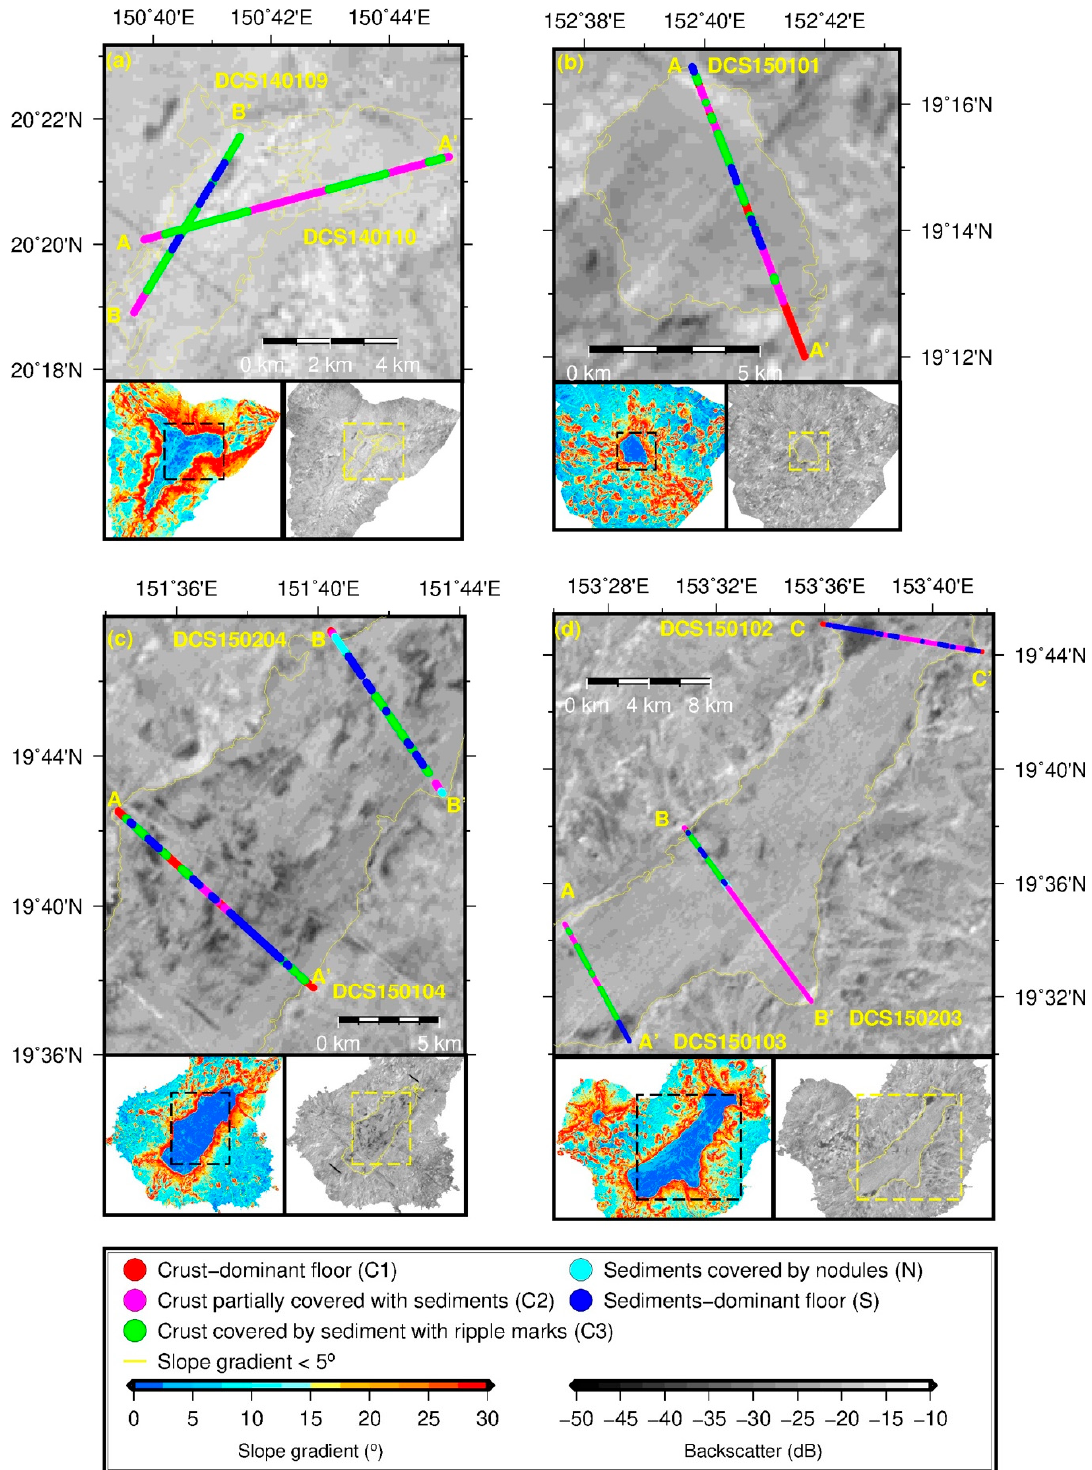
Figure 8. Expanded MBES backscatter map showing distribution of the seabed types within the summit in Type 2 ′ s seamounts observed from DCS surveys: the local area of ( a ) OSM 16, ( b ) OSM 18, ( c ) OSM 17, and ( d ) OSM 19. Yellow dashed contours indicate summit areas with a gradient of <5°. The two panels below the expanded map (Figure 8a–d) show information of (a) slope gradient and (b) acoustic backscatter, corresponding to the flanks and summit of target’s seamounts.